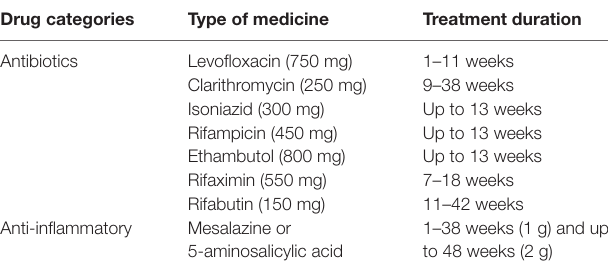
taBLe 1 | summary of treatment regimen up to 12 months.